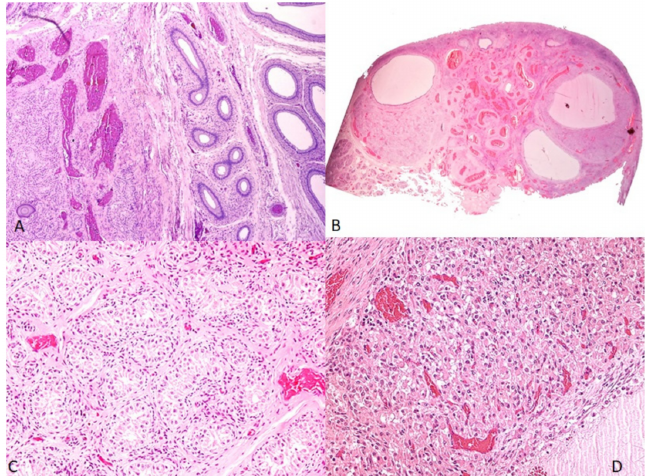
Figure 2. ( A ) Right-side gonad, testicle, with testicular and epidydimal components (H&E, 100 × ); ( B ) Left-side gonad, the ovotestis (H&E, 7.5 × ); ( C ) testicle-like structures of the ovotestis, evidencing seminiferous tubules lined by Sertoli cells (H&E, 100 × ); ( D ) ovarian structures of the ovotestis, showing secondary follicles and corpus luteum (H&E. 100 × ).